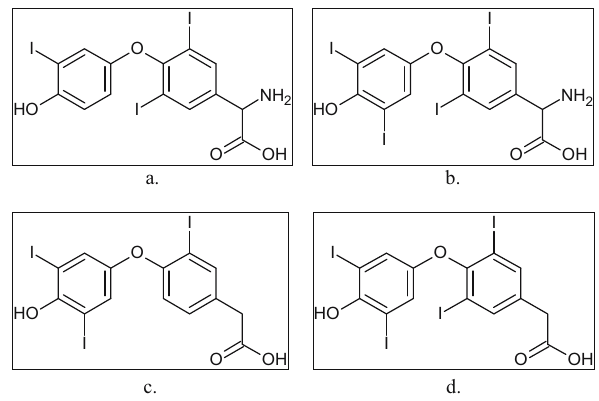
Figure 6: Tetrac and related products: ( a ) Tetrac ( R 1 = R = OH ) and ( b ) various semisynthetic